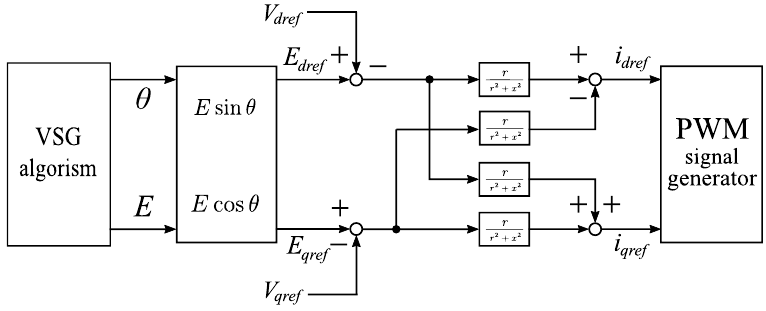
Figure 8. Block diagram of virtual impedance model.